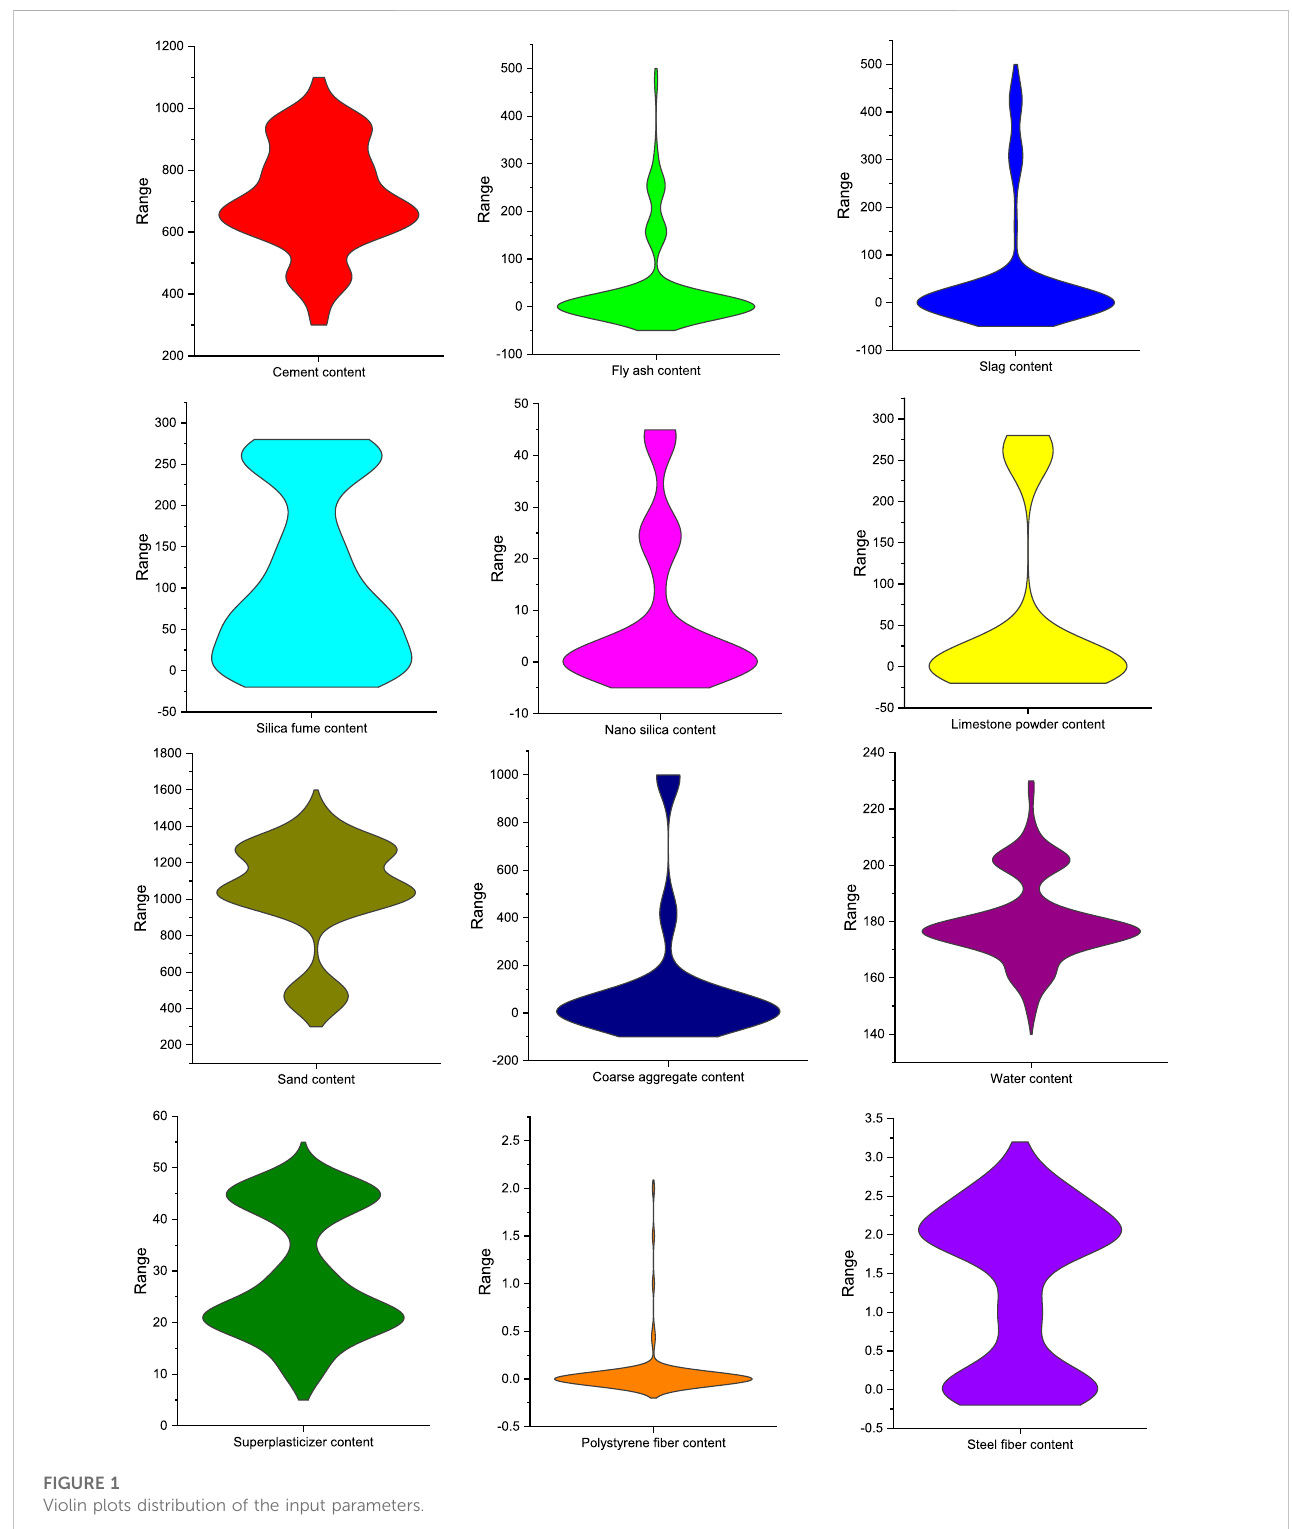
FIGURE 1 Violin plots distribution of the input